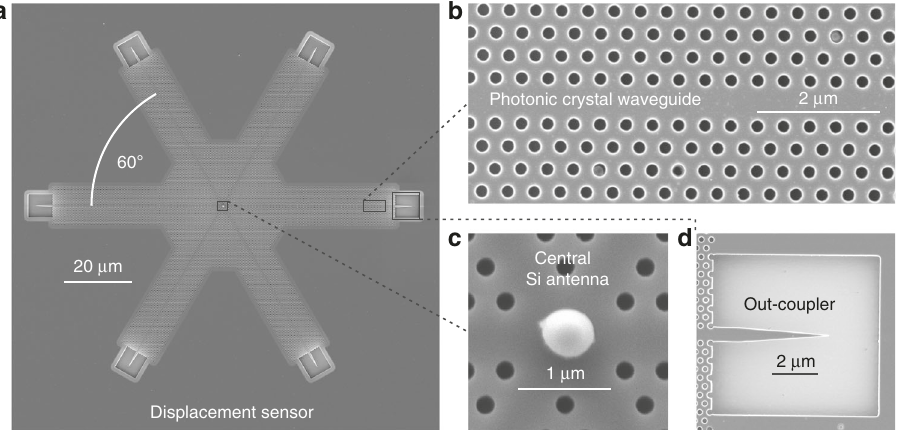
Fig. 1 Position-dependent directionality. a Electromagnetic fi eld distribution of a tightly focused radially polarized beam. The focal energy density E ¼ ϵ 0 E j j 2 (upper left), the longitudinal electric, w z j j 2 (upper right) and the azimuthal magnetic w ϕ distributions of the radial electric, w r E ¼ ϵ 0 r z E 4 4 (lower left) components are shown. The distributions of w ϕ E , w r H , and w z H are strictly zero everywhere (lower right panel). The black arrows indicate the local orientation of the corresponding fi elds, while the relative phases are shown as insets. The crosses and the squares in each panel mark two especi fi c positions within the beam. b Angular spectrum (AS) electric fi eld intensity distribution j ~ E j 2 of an electric dipole oriented in z -direction (expected at the position marked by the crosses in a ). c The distribution of j ~ E j 2 for a combination of an electric dipole oriented in z -direction and a magnetic dipole oriented in y -direction (expected at the position marked by the square in a ). At the boundary between propagating and evanescent parts of the AS (see dotted black circles), j ~ E j 2 exhibits a singularity. The color-code is scaled in order to achieve a good visibility in the region of interest, while higher values of j ~ E j 2 (>1 in the chosen color-map) are not considered (see gray areas). The six black triangles indicate the k -vectors for which the light is estimated to couple to the six arms of the photonic crystal structure described below.